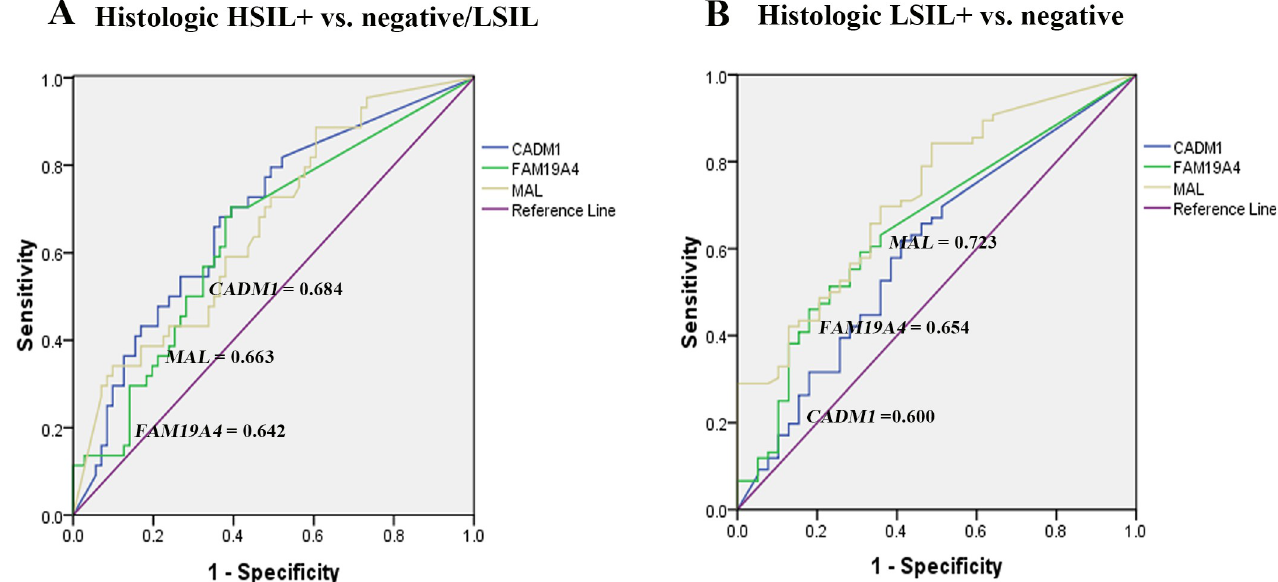
Fig 5. The ROC curve analysis of three methylation markers in differentiating histologic HSIL+ from negative/LSIL (A), and histologic LSIL+ from negative histology (B).